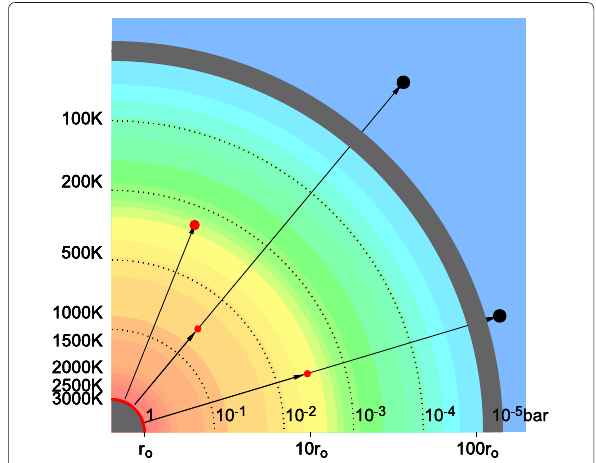
Fig. 9 Schematic diagram of a steady-state vapor cloud with a boiling duston surface ( r = r 0 ) at constant T 0 = 3000 K and P 0 = 1 bar. Adiabatic expansion of the vapor cloud ends at r ∼ 100 r 0 , where its pressure becomes equivalent to that of the disk gas (assumed 10 − 5 bar) and a whole condensation occurs as shown in gray belt. The abscissa is in log scale except r < r 0 . Jet-droplets, shown in filled circle, eject from the duston surface and may grow in size by recondensation of the vapor and by incorporation of condensed particles on their way